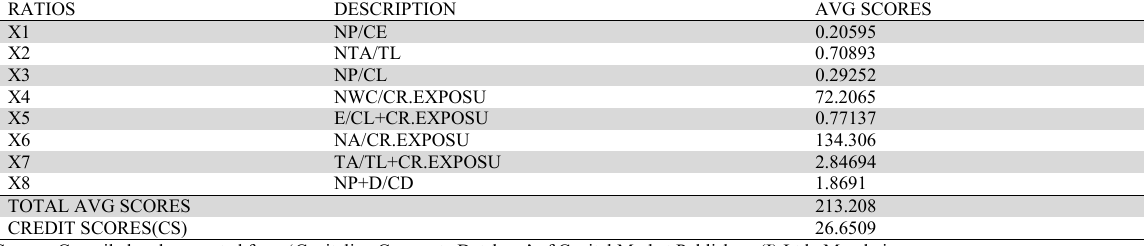
Measurement description model – Ratio measurement (Titan) RATIOS DESCRIPTION